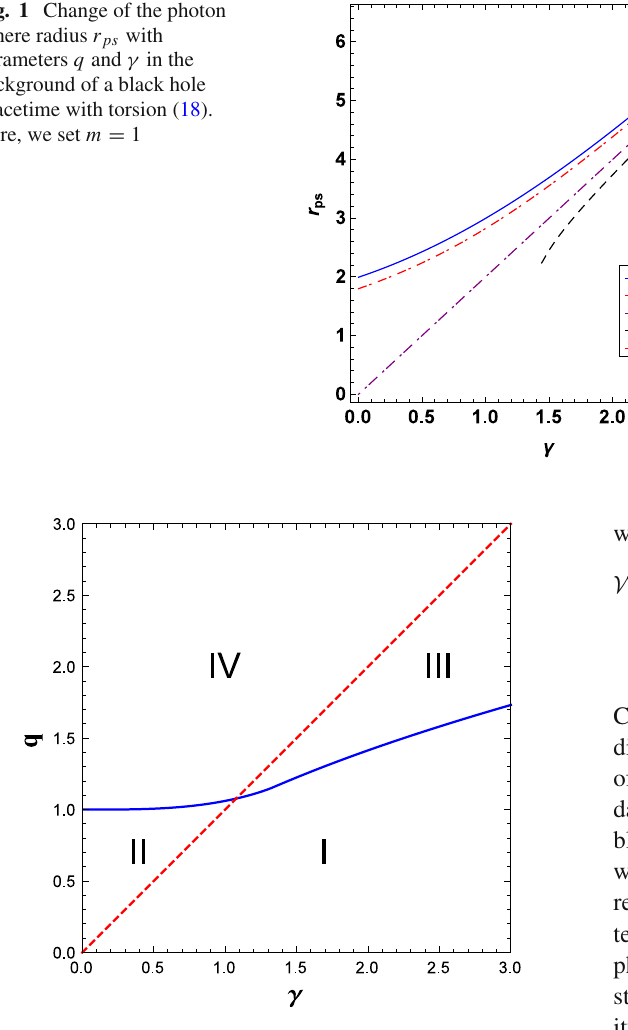
Fig. 2 The boundary of the existence of horizon (red dashed line) and of the photon sphere (blue line) in the background of a black hole spacetime with torsion (18). Here, we set m =